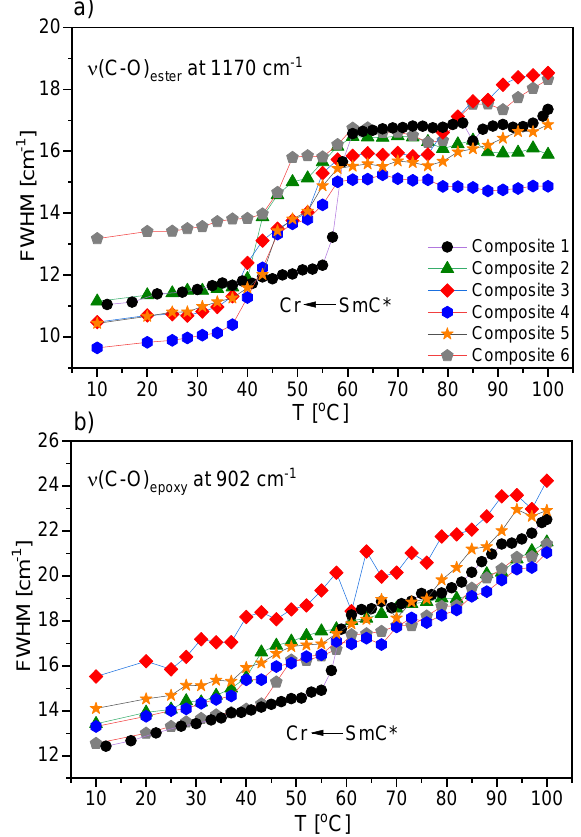
Figure 20. Temperature dependencies of the full width at half maximum (FWHM) of two selected IR bands connected to ν (C-O) ester ( a ) and ν (C-O) epoxy ( b ) modes obtained for pure EHPDB and nanocomposites during cooling from the isotropic phase. The positions of these two bands are given for pure EHPDB at room temperature. The legend in graph ( a ) is the same for all graphs.